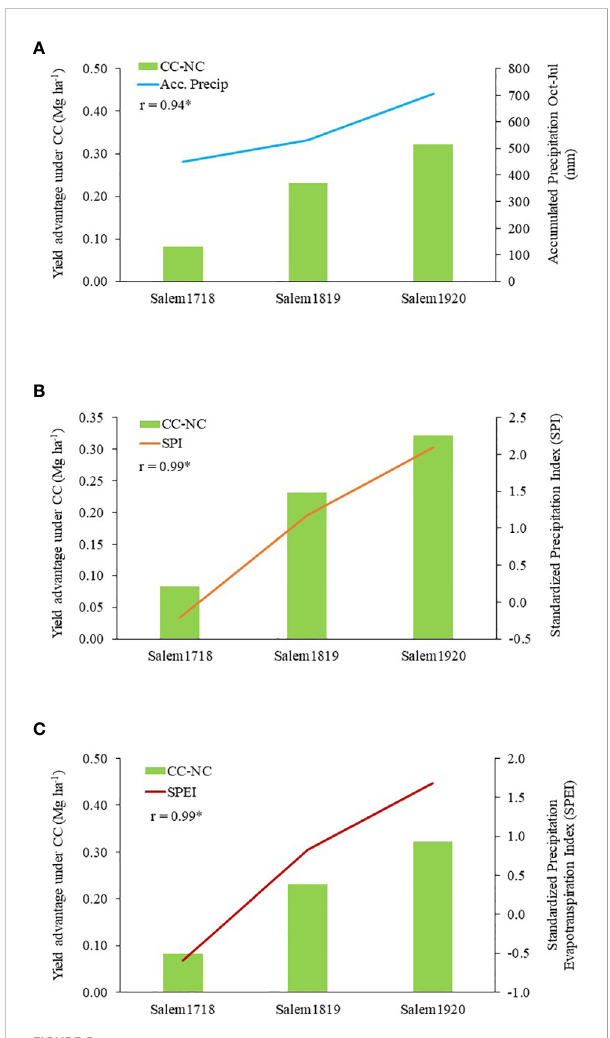
FIGURE 5 Plots showing hydroclimatological parameters (A) accumulated precipitation (mm) during October-July before cover crop planting, (B) Standardized Precipitation Index (SPI), and (C) Standard Precipitation Evapotranspiration Index (SPEI) in fl uencing yield advantage under cover cropping (difference in yields under cover crop and no cover crop control plots) at Salem study site during three cropping seasons 2017-18, 2018-19, and 2019-2020. '*' indicates statistically signi fi cant correlation between the cash crop yield and hydroclimatological parameter.